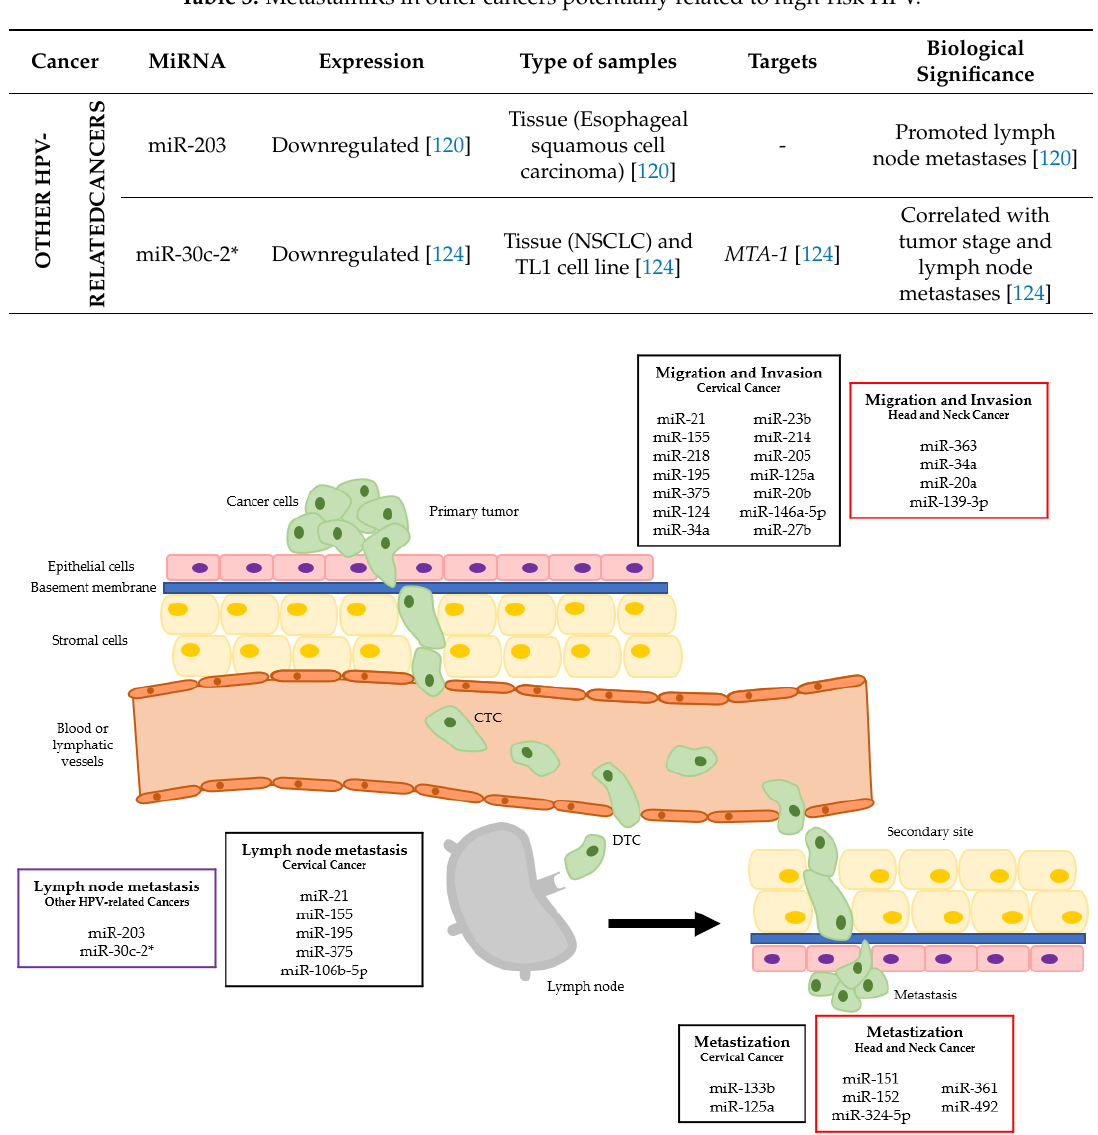
Table 3. MetastamiRs in other cancers potentially related to high-risk HPV.